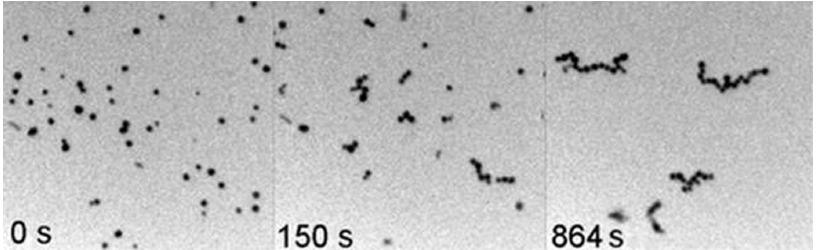
Figure 5 In situ visualization of self-assembly of charged gold nanoparticles. Reprinted (adapted) with permission from [5]. Copyright (2013) American Chemical